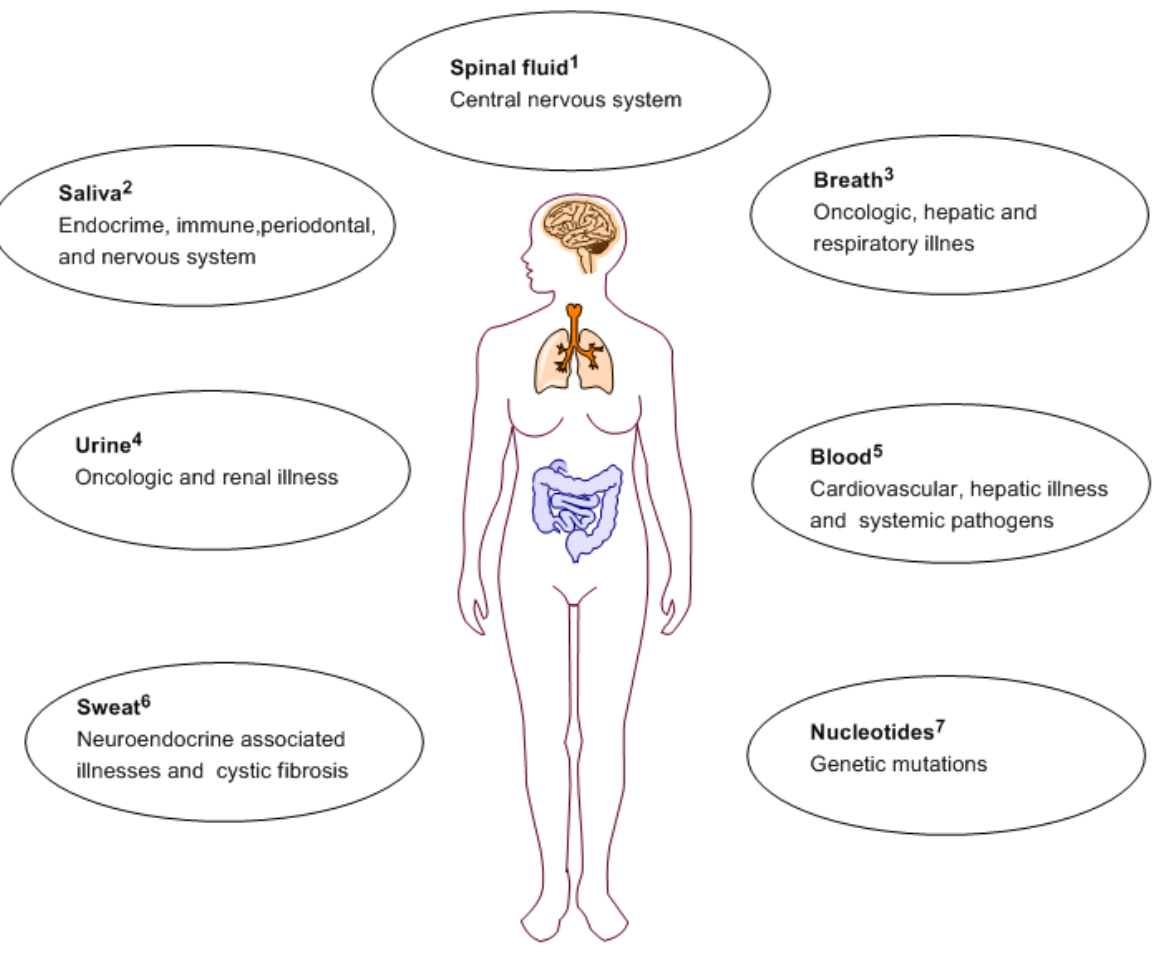
Figure 1. Routes of obtaining biomarkers for a variety of illnesses. 1. Spinal fluid [11]; 2. Saliva [12]; 3. Breath [13]; 4. Urine [14]; 5. Blood [15]; 6. Sweat [16]; 7.Nucleotides